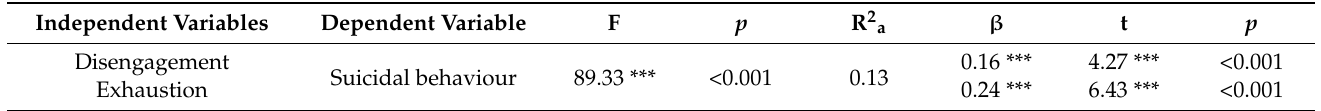
Table 5. Multiple linear regression results (H1).